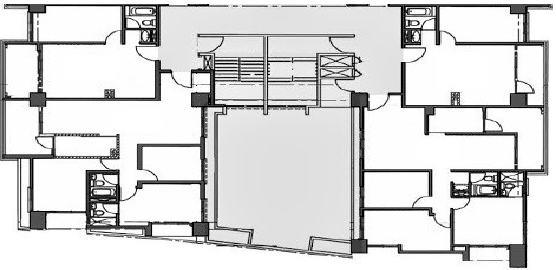
Figure 7. A blueprint image for a company that designs, builds, and sells houses.